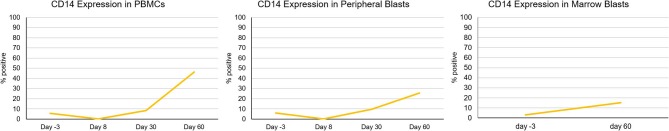
Increase in differentiation-associated immunophenotype in blood and marrow in a patient. Patient 8 showed a notable increase in percentage of cells expressing CD14, a surface marker associated with myeloid differentiation throughout the study period. Percent expression indicates fraction of cells expressing CD14 within CD45+ leukocytes (PBMCs), circulating blasts, or marrow blasts.